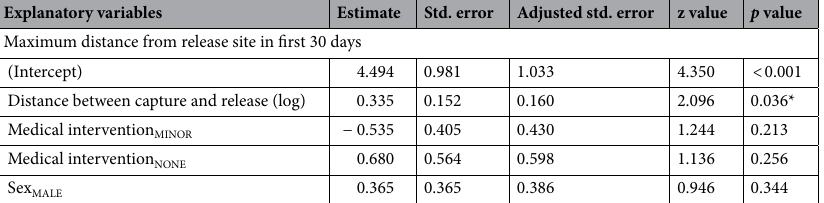
Table 2. Summary output from model averaging the top (∆AIC ≤ 2) generalised linear mixed models showing relationships (conditional average) with the maximum distance koalas moved from their release site within 30 days after release from rehabilitation. Significant relationships are identified by asterisks. The categorical reference groups are: major for medical intervention, and female for sex.